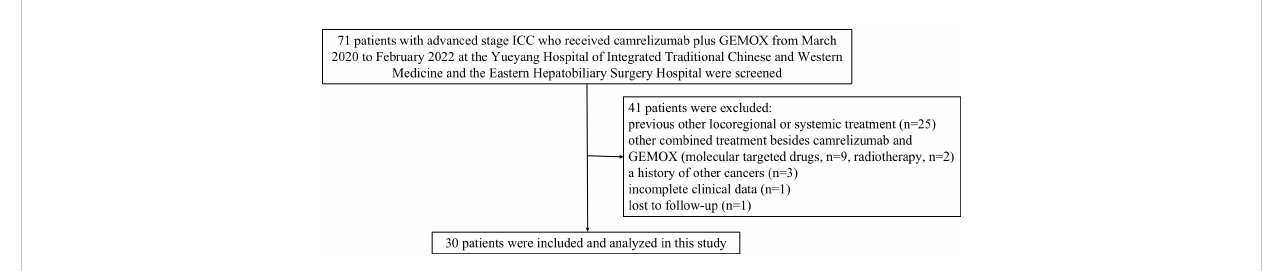
FIGURE 1 Study design and fl ow diagram of this study. ICC, intrahepatic cholangiocarcinoma; GEMOX, gemcitabine and